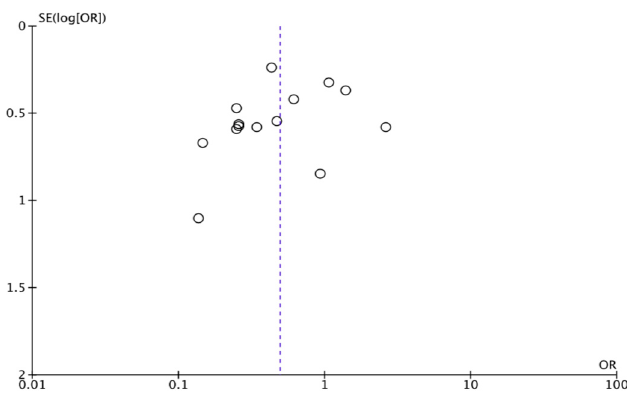
Figure A1. Funnel plot of urinary tract infection for early (<3 weeks) versus late (>3 weeks) stent removal.